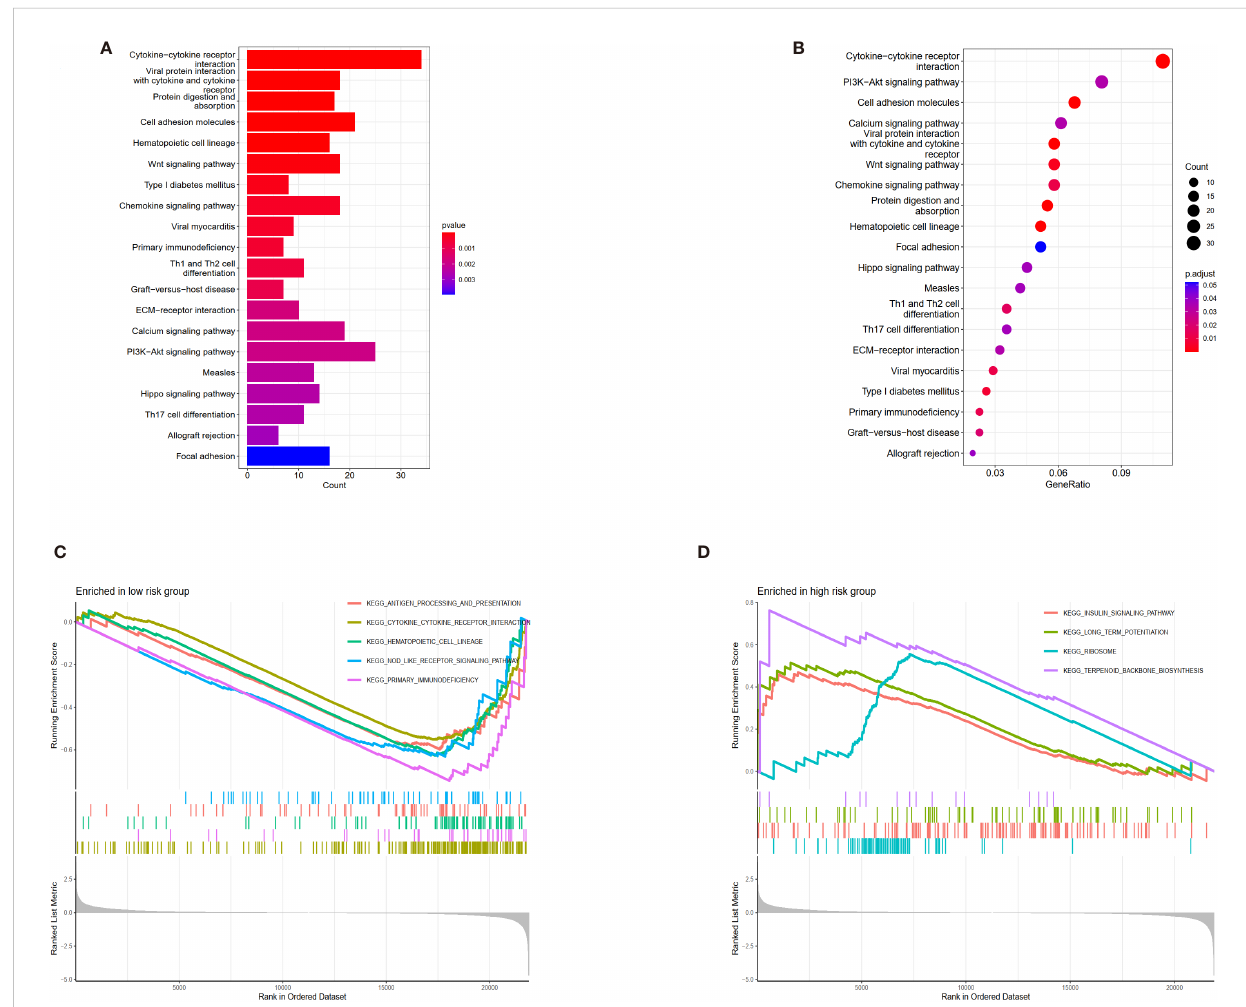
FIGURE 7 Kyoto Encyclopedia of Genes and Genomes (KEGG) and Gene Set Enrichment Analysis (GSEA) of different risk subgroups. (A) Bar plot of KEGG. (B) Bubble of KEGG. (C) Multiple pathways and functions were found to be enriched in low-risk anoikis-related lncRNA. (D) GSEA analysis in high- risk